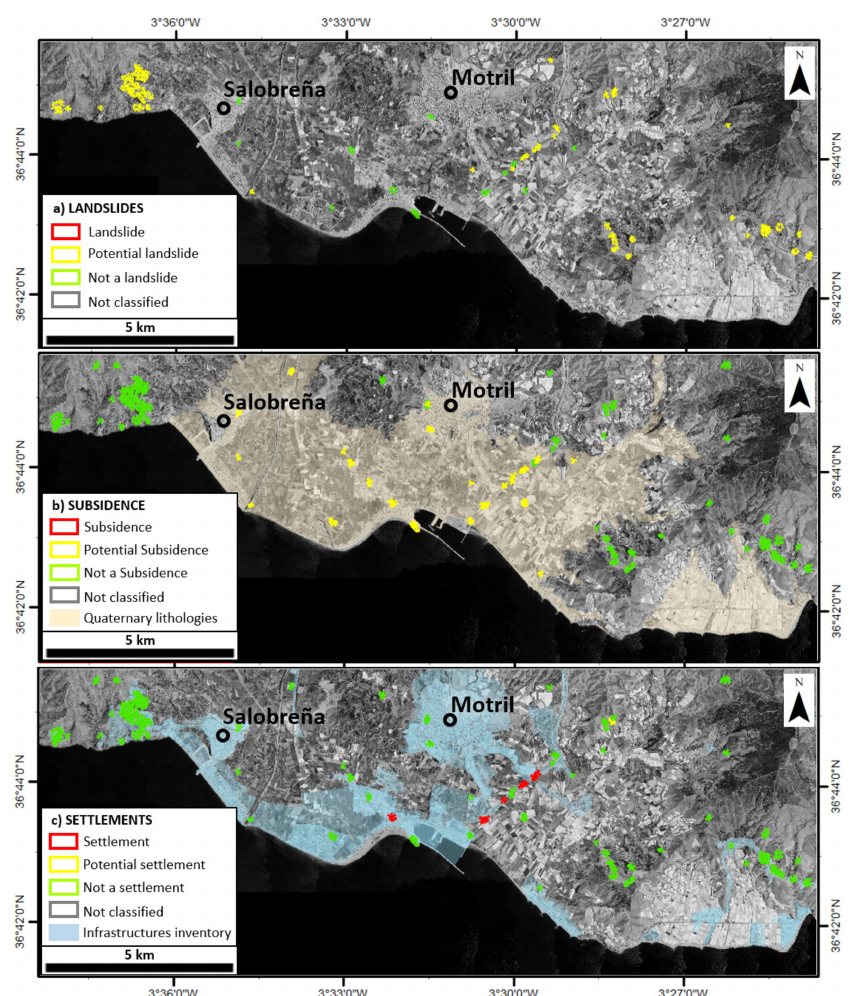
Figure 15. Classification of ADA in the study area located in the South of Spain (province of Granada, Andaluc í